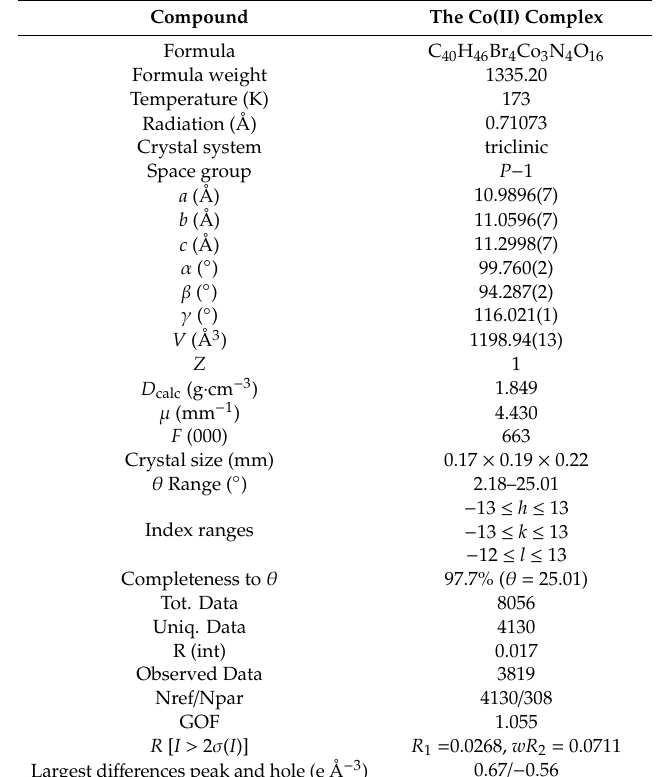
Table 1. Crystal data for the Co(II) complex.